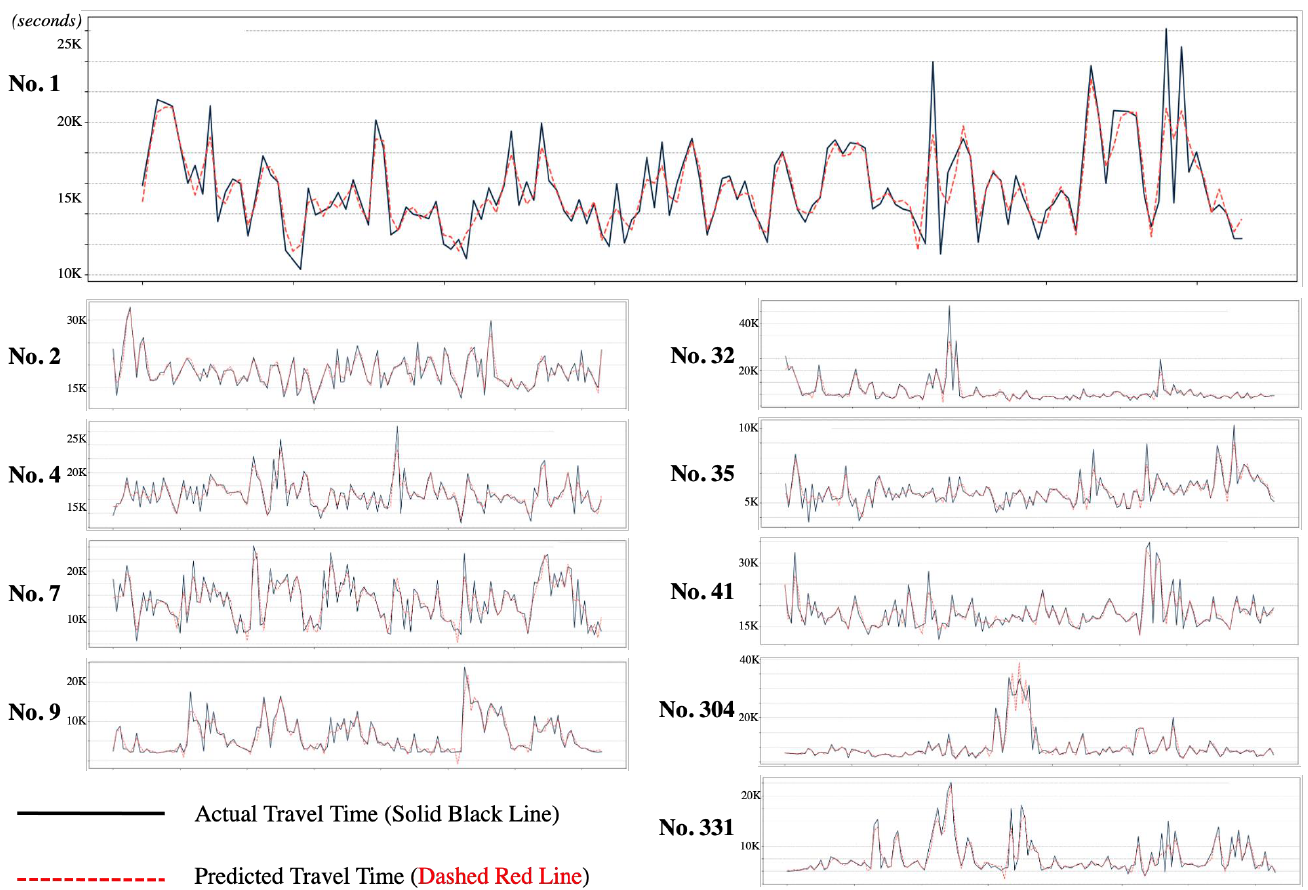
Figure 8. Line chart visualizing the comparison between actual values (black solid line) and predicted values (red dashed line) using the SA-LSTM model with Butterworth low-pass filter from each road segment of a few days.